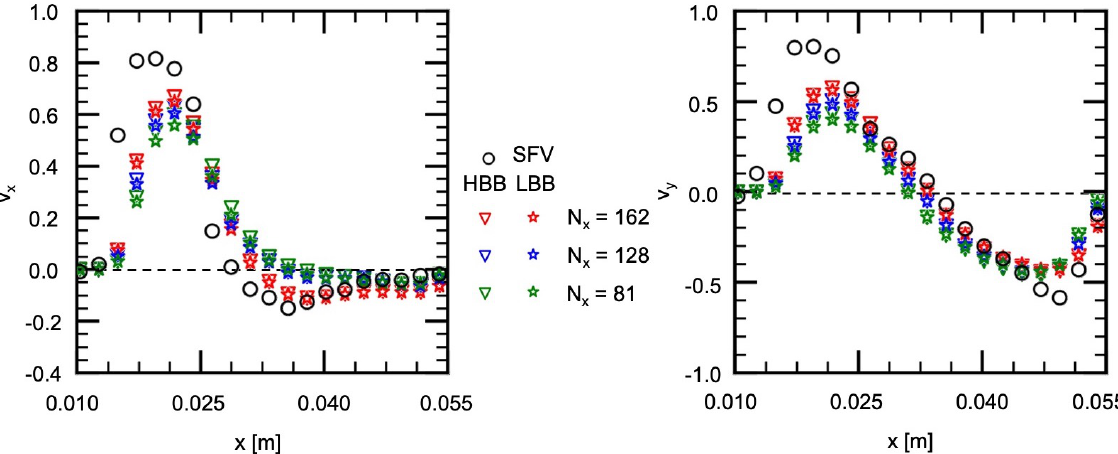
Figure 13. Comparison of velocity components between HBB and LBB at lower spatial resolutions (line